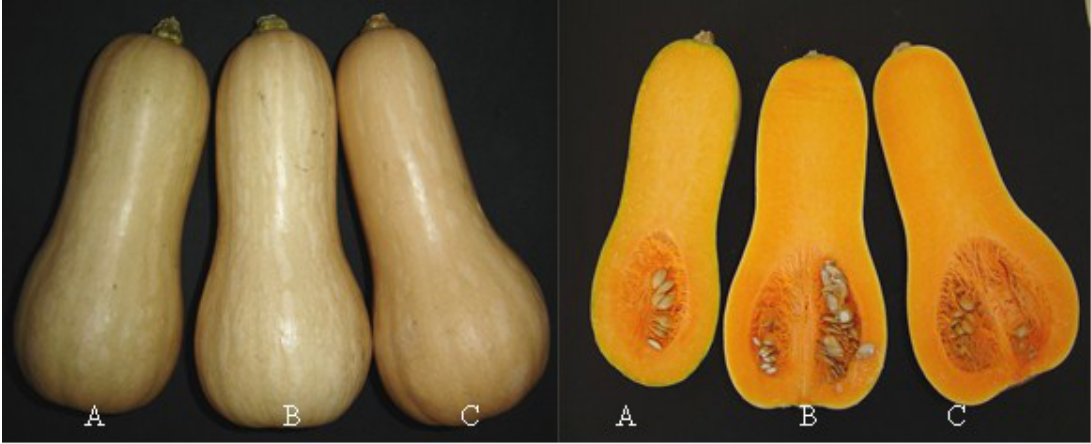
Figure 1. Stages of commercial maturity of the fruits. (A): immature; (B): mature; (C): very